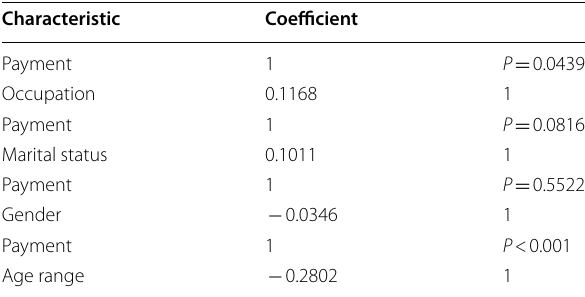
Table 3 Correlation coefficients between informal